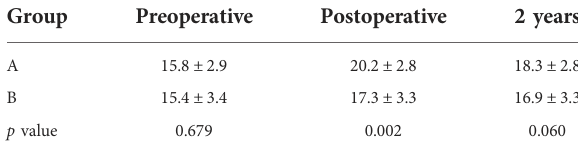
TABLE 7 Operative segmental lordotic angle of two groups (°). Group